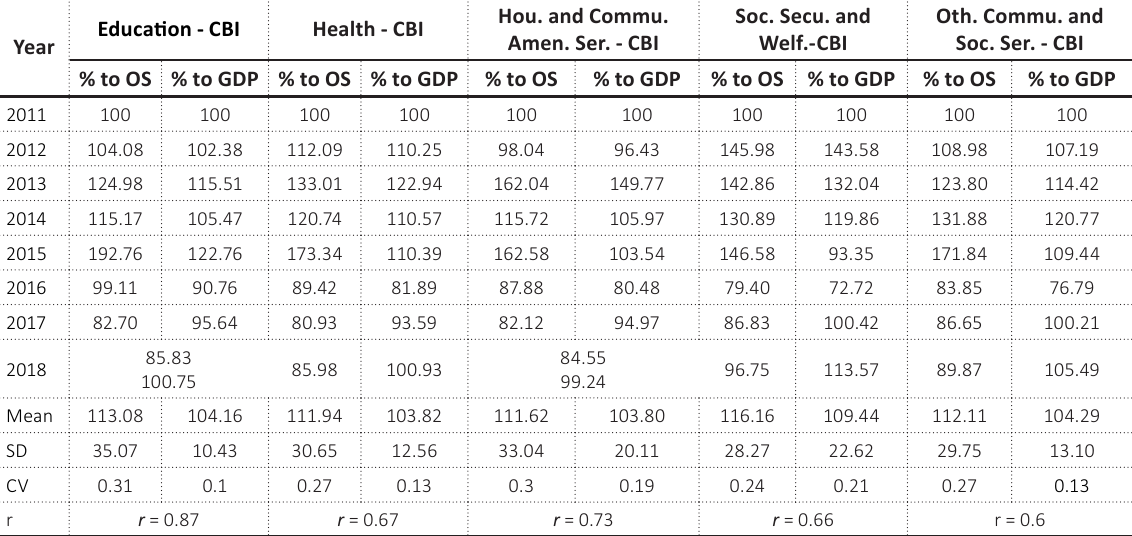
Table 5. Comparative sensitivity of public spending proportionate to the oil sector and GDP Source: Own CBI calculations of the percentage of public spending to OSR and GDP based on the proportionate percentage given in Appendices A3 and A4. Hou. and Health - CBI